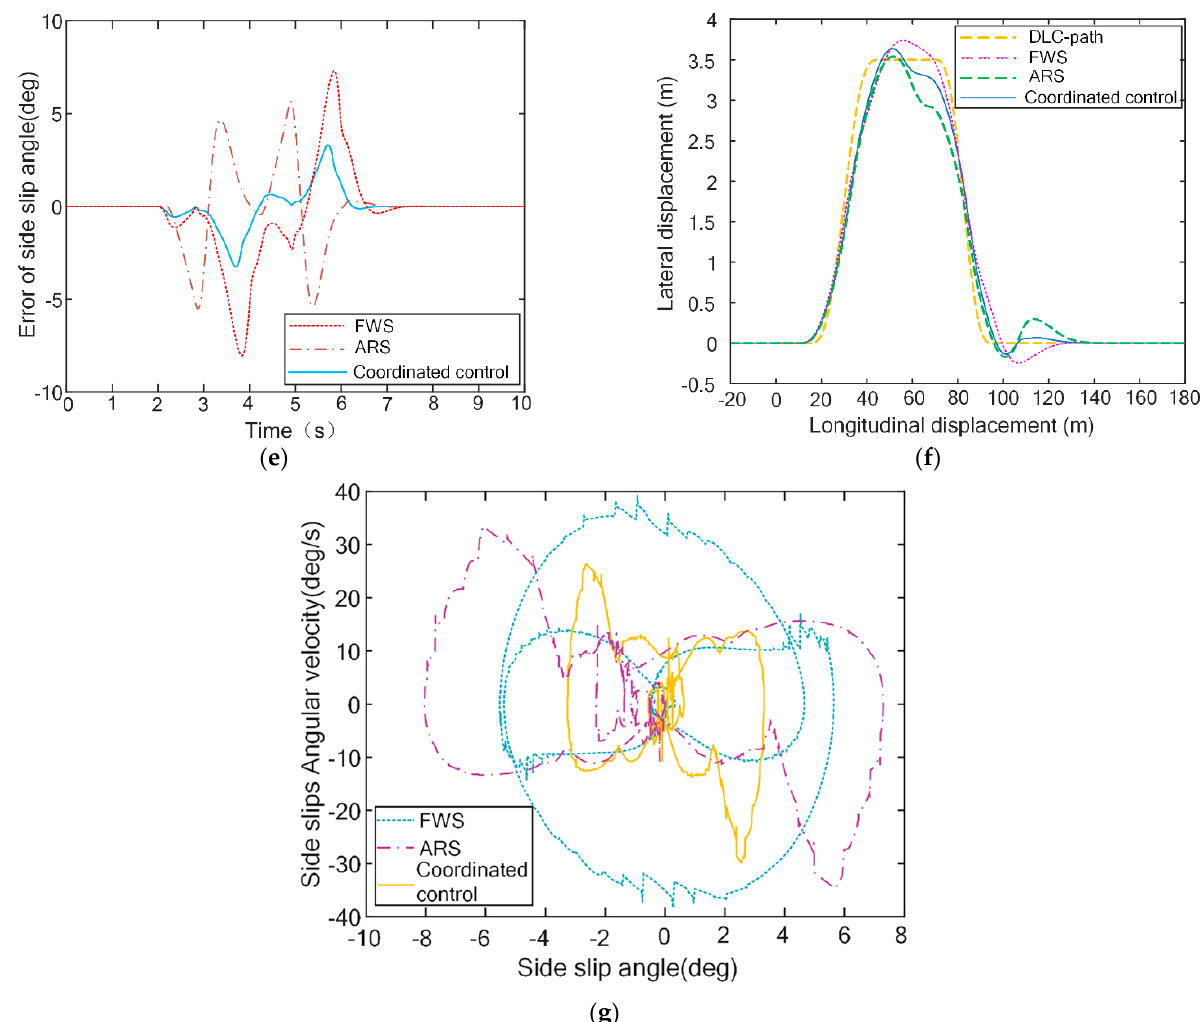
Figure 17. Hardware-in-the-loop test results under double lane-change test ( a ) The curve of wheel steering angle change. ( b ) Wheel torque under coordinated control. ( c ) Variation curve of vehicle speed. ( d ) Response curve of the yaw rate. ( e ) Error response curve of the side slip angle. ( f ) Displacement of the center of mass of the vehicle. ( g ) Phase plane diagram of the side slip angle.